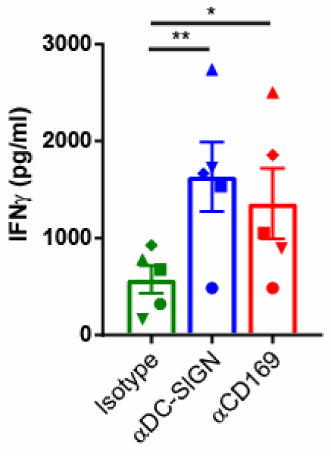
Figure 5. Targeting melanoma Ag to CD169 on human MoDCs results in melanoma Ag presentation to T cells. IFN γ production by gp100 280–288 -specific HLA-A2.1 restricted T cell line after 24 h